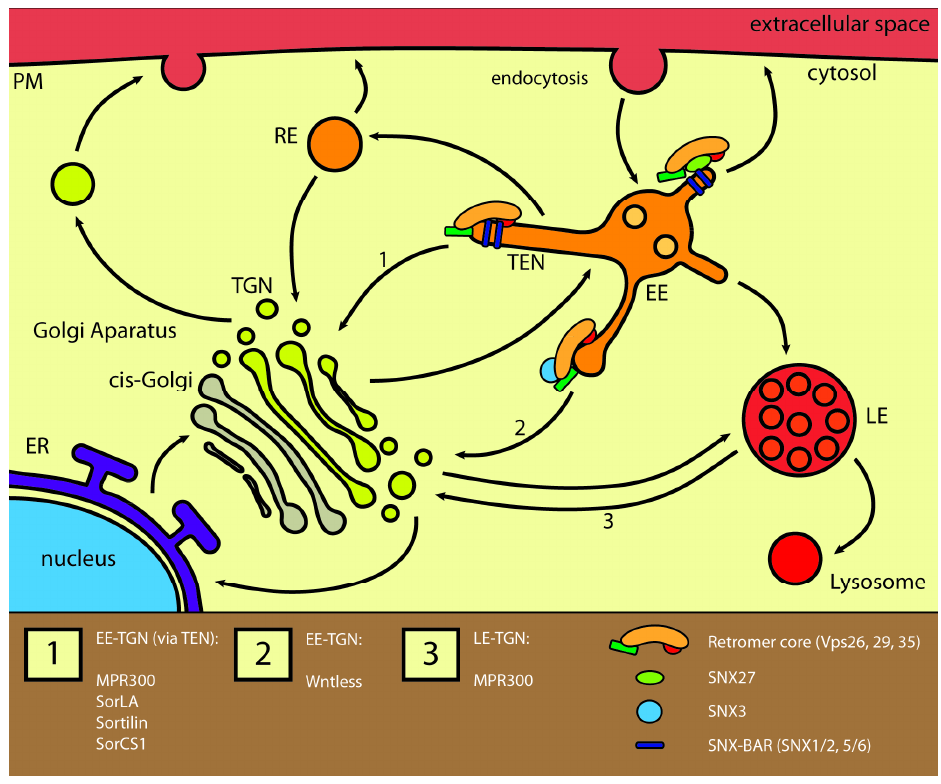
Figure 1. Retrograde trafficking of receptors. Retrograde trafficking can be divided into